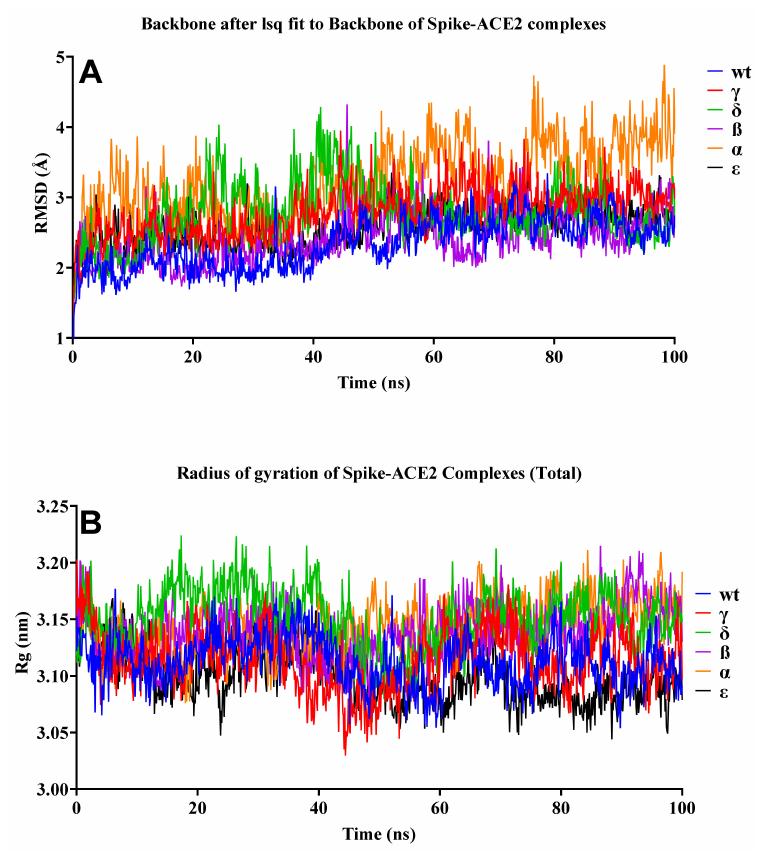
Figure 9. RMSD and Rg of the S–hACE2 complexes. ( A ) RMSD change in WT and mutant S–hACE2 complex backbones during 100-ns MD simulation. ( B ) Total Rg change over